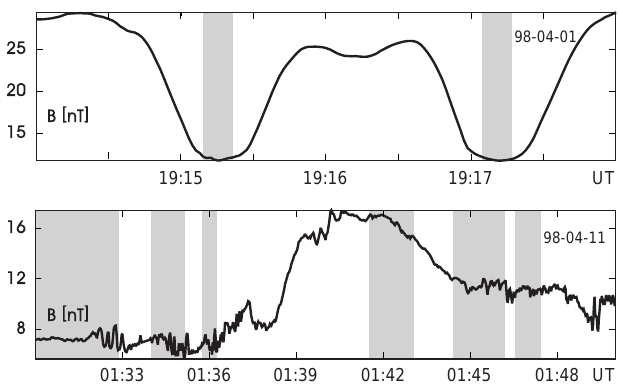
Fig. 4. Ambient magnetic field strength and occurrence of electron whistlers in the shaded intervals